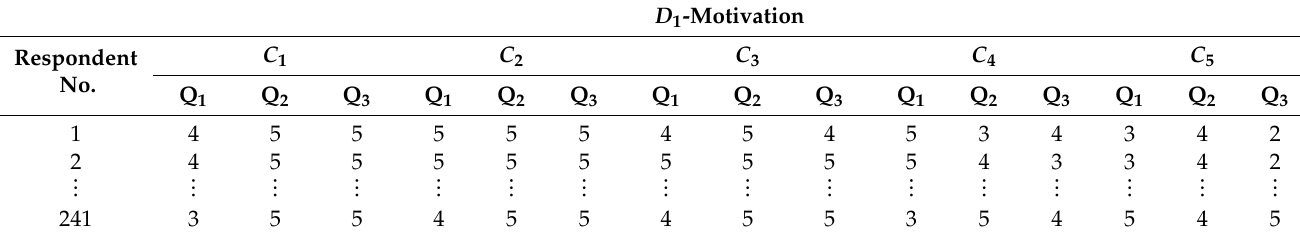
Table 2. The encoded data.